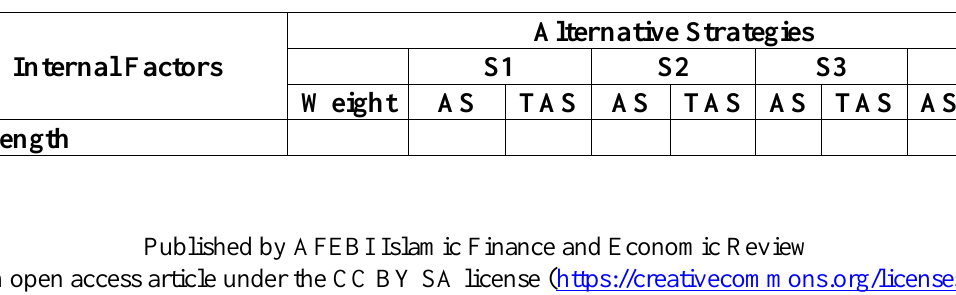
Table 5. Total Attractive Score (TAS) Internal